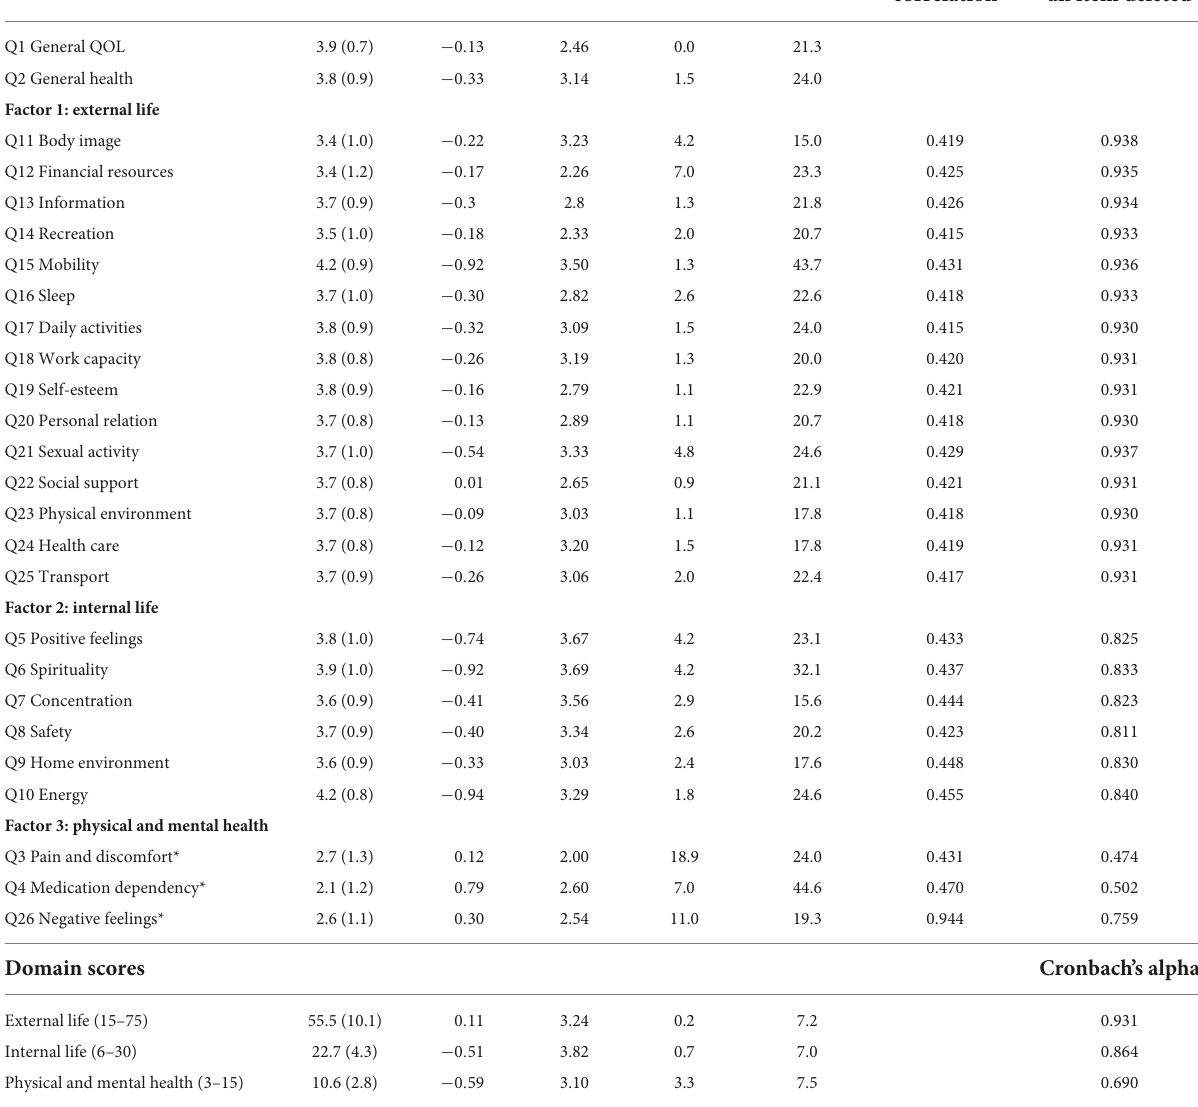
TABLE 4 Basic descriptions and reliability of WHOQOL-BREF